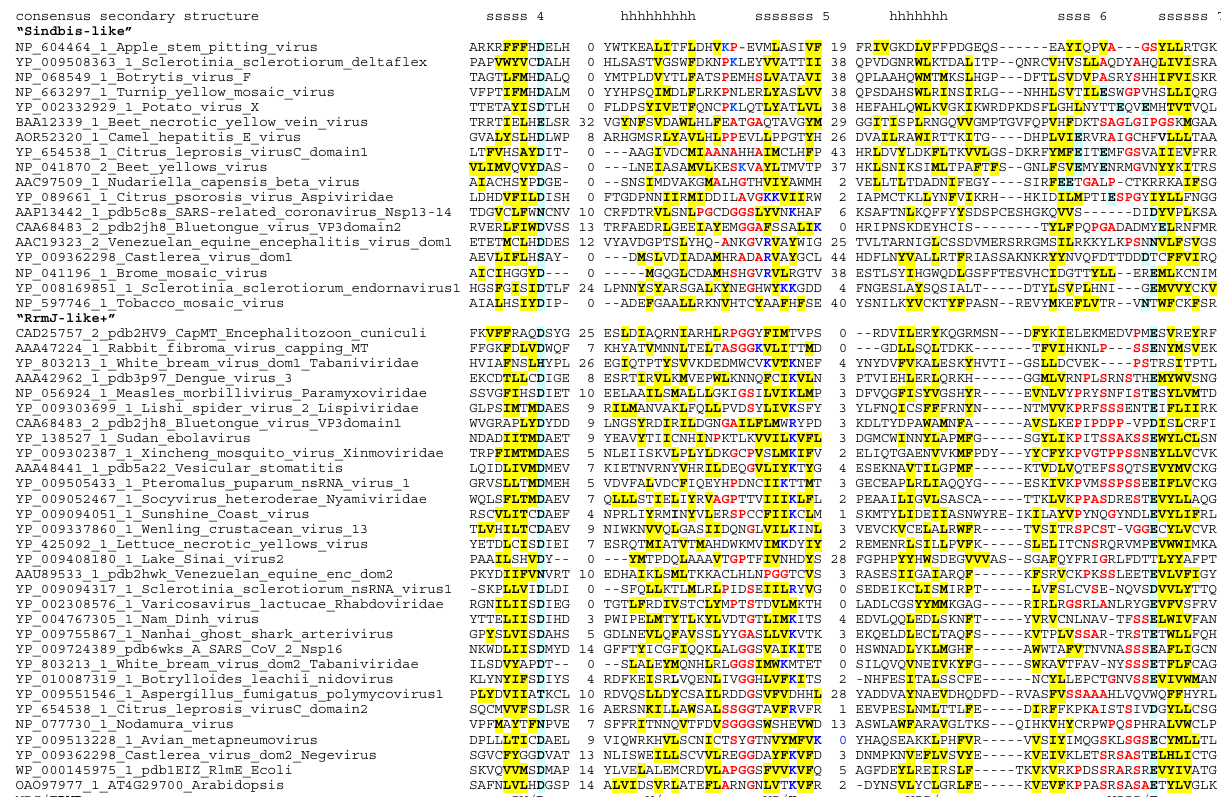
Figure 1. Multiple sequence alignment of SAM-dependent methyltransferases encoded by representative genomes of Riboviria . Sequence identifiers in GenBank and PDB, virus species names and the family names, as of 2021, are shown on the left (truncated in the lower pane). The distance from the N-termini of the proteins, in amino acids, is shown before each sequence, and the lengths of less-conserved inserts are also shown. In the consensus secondary structure lines above the alignment, s stands for a β -strand and h stands for an α -helix; the positions are marked if the residue is found in a strand or a helix in more than a half of the known spatial structures, and the numbering of the strands within the Rossmann fold is provided. Conserved hydrophobic residues (I, L, M, V, F, Y, W) are indicated by yellow highlight, conserved small-side-chain or turn/kink-prone residues (A, G, S, P) are indicated by bold type and red color, conserved positively charged residues (K, R) are in bold type and blue color, and conserved acidic or amine side chains (D, E, N, Q) are highlighted in cyan. In Motif I, blue highlight is used to mark additional residues with potential negative charge (C, H, S, T and Y). Prior motif nomenclature (see text) is shown under the alignment. The order in which the sequences are sorted is explained in the Section